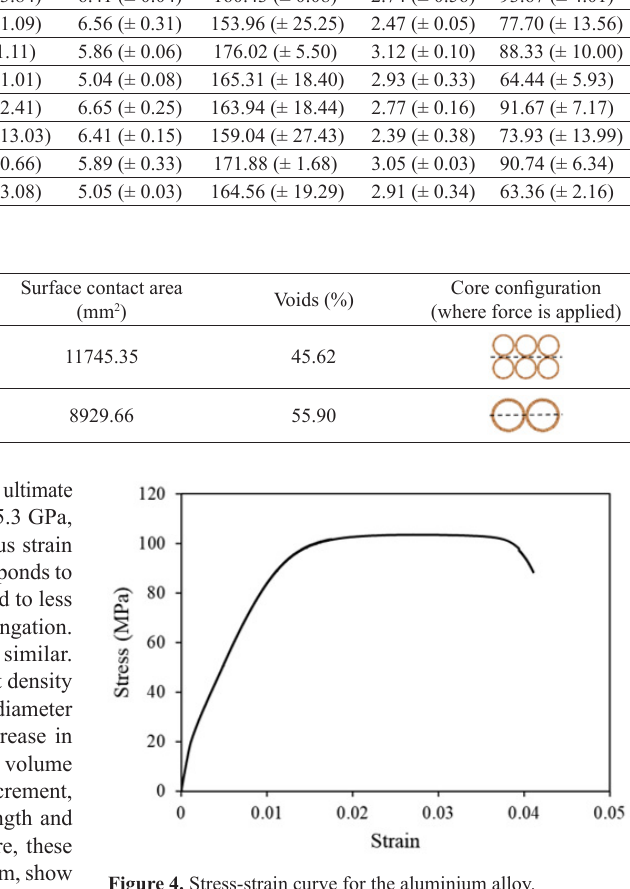
Figure 4. Stress-strain curve for the aluminium alloy.